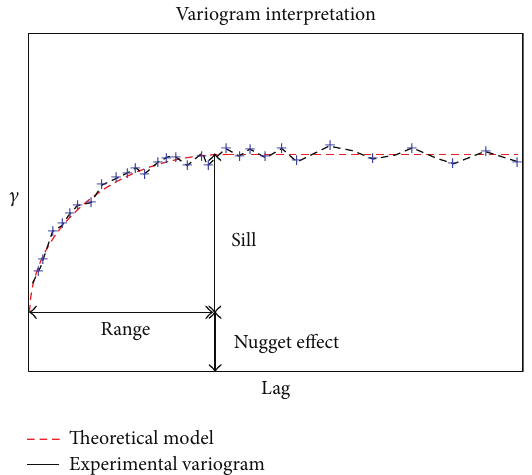
Figure 2: Semivariogram interpretation schematic explanation.